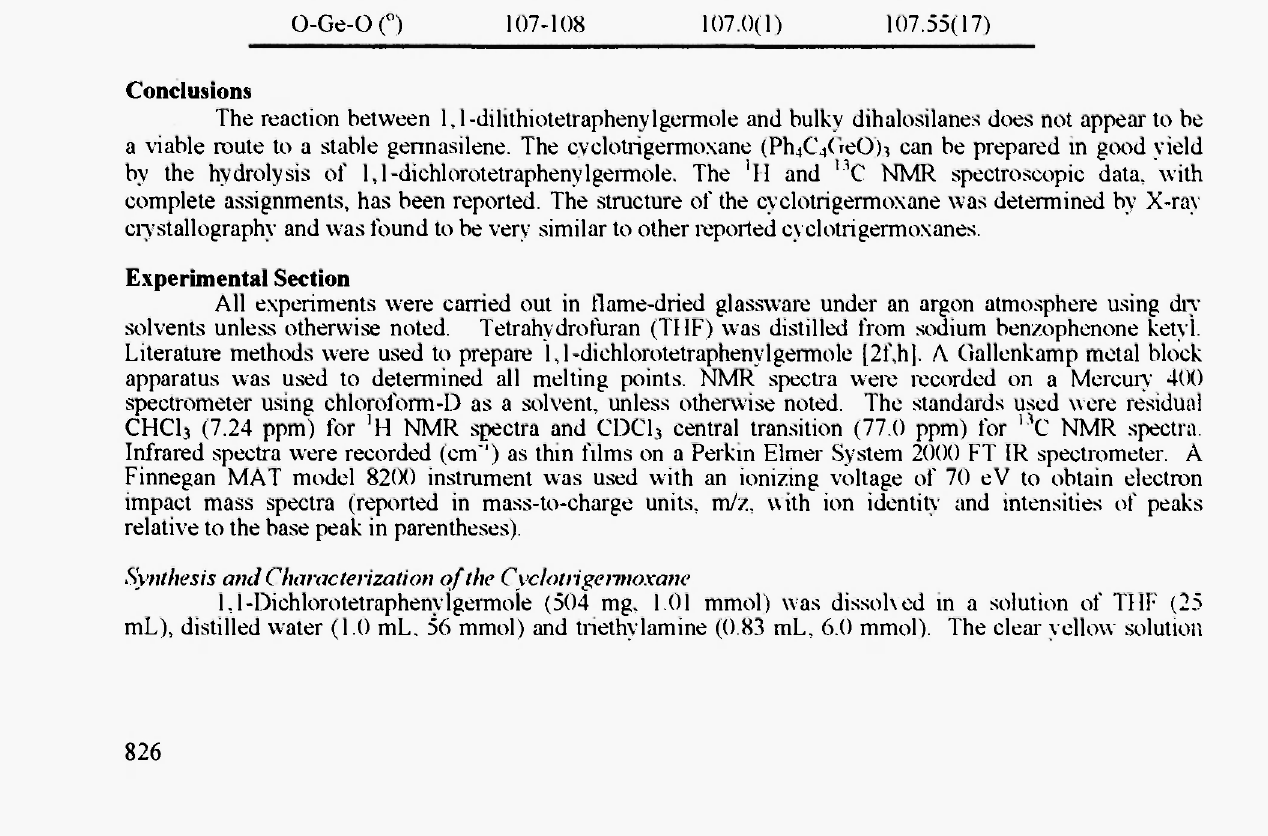
Figure 3. Molecular Structure of Cyclotrigermoxane 1 Table 3. Bond Lengths and Angles for